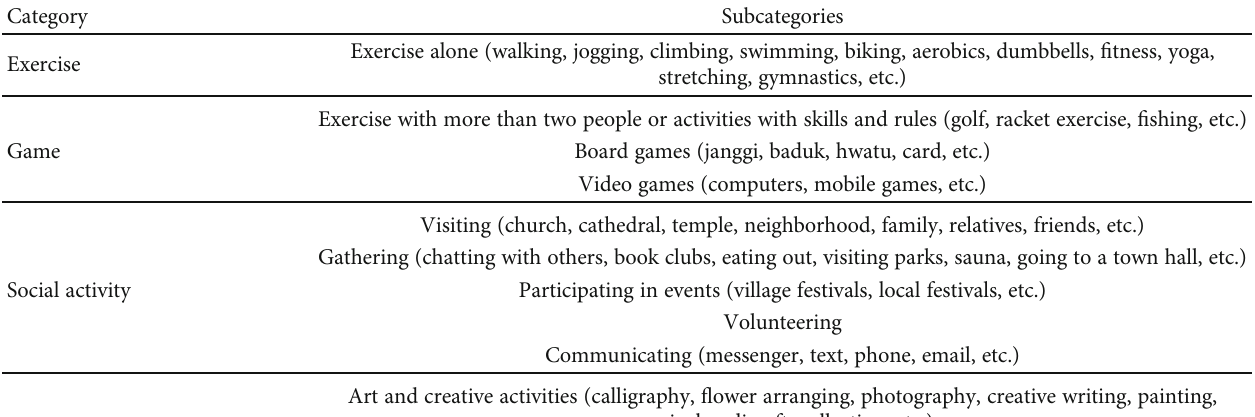
Table 3: Items of leisure participation assessments for the